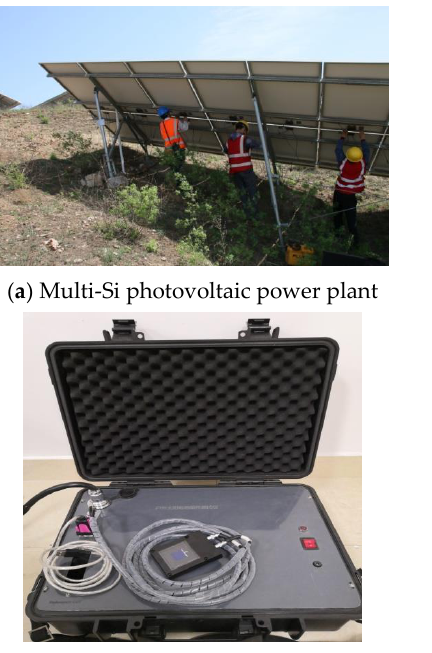
Figure 1. The studied photovoltaic power plants and experimental setup.